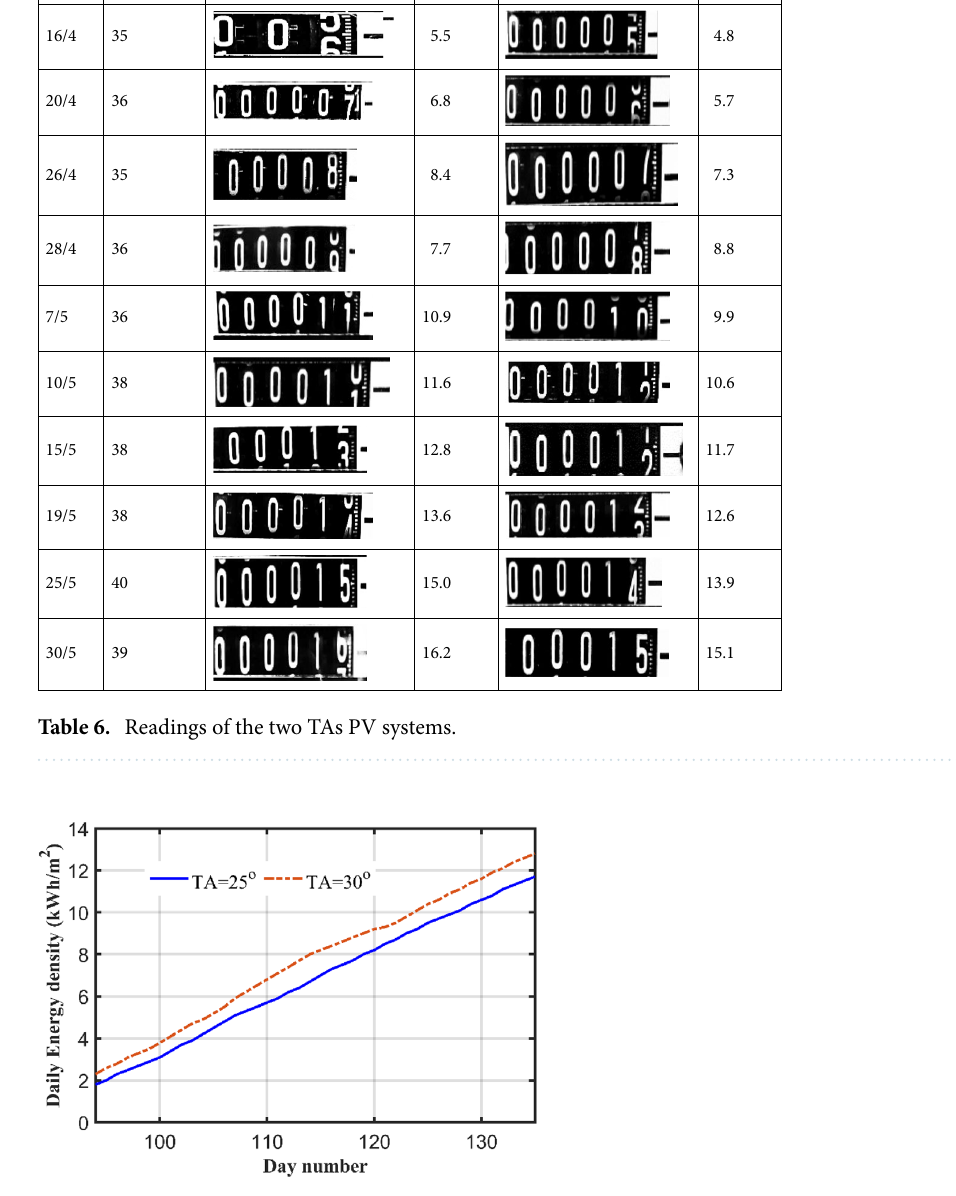
Figure 10. Energy consumed by both systems during the period starting from 4th of April to 30 of